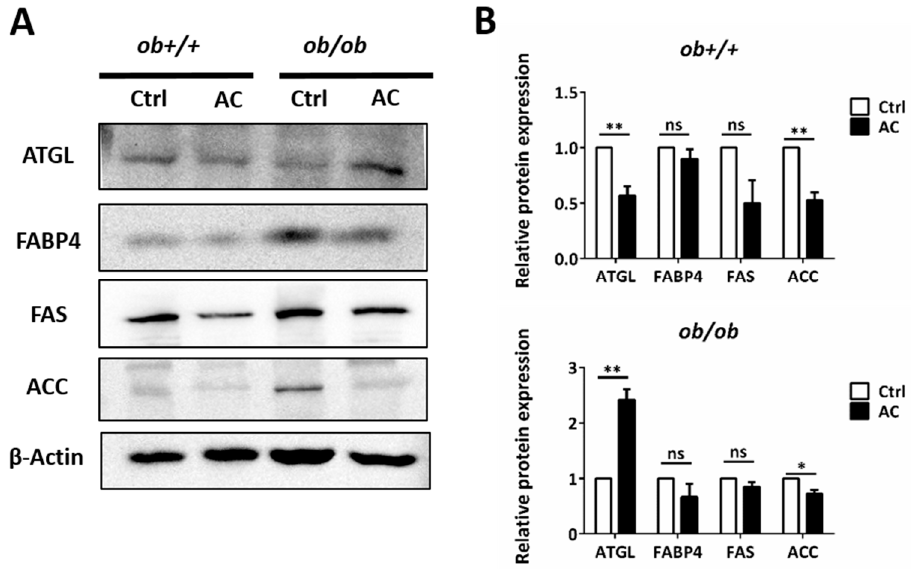
Figure 4. AC promotes expression of a lipolysis-associated protein in the EWAT of ob +/+ and ob / ob mice. ( A ) Immunoblot analysis of lipolysis pathway protein. ( B ) Quantification and comparison of protein expression in ob +/+ -Ctrl or ob / ob -Ctrl mice. All data are expressed as mean ± SEM, * p < 0.05, ** p < 0.01, *** p < 0.001. Non-significant; ns. n = 4–8 mice in each group. All experiments were repeated thrice.